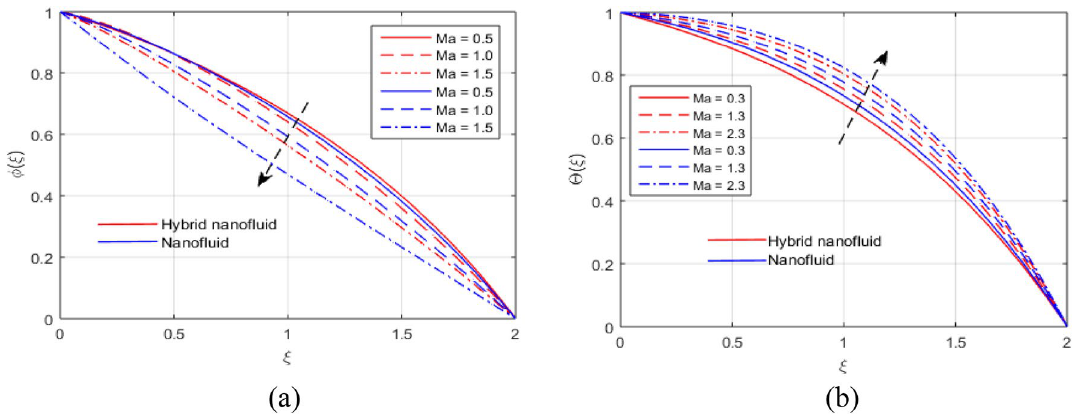
Figure 18. ( a , b ) Effect of Ma on φ(ξ) and �(ξ)